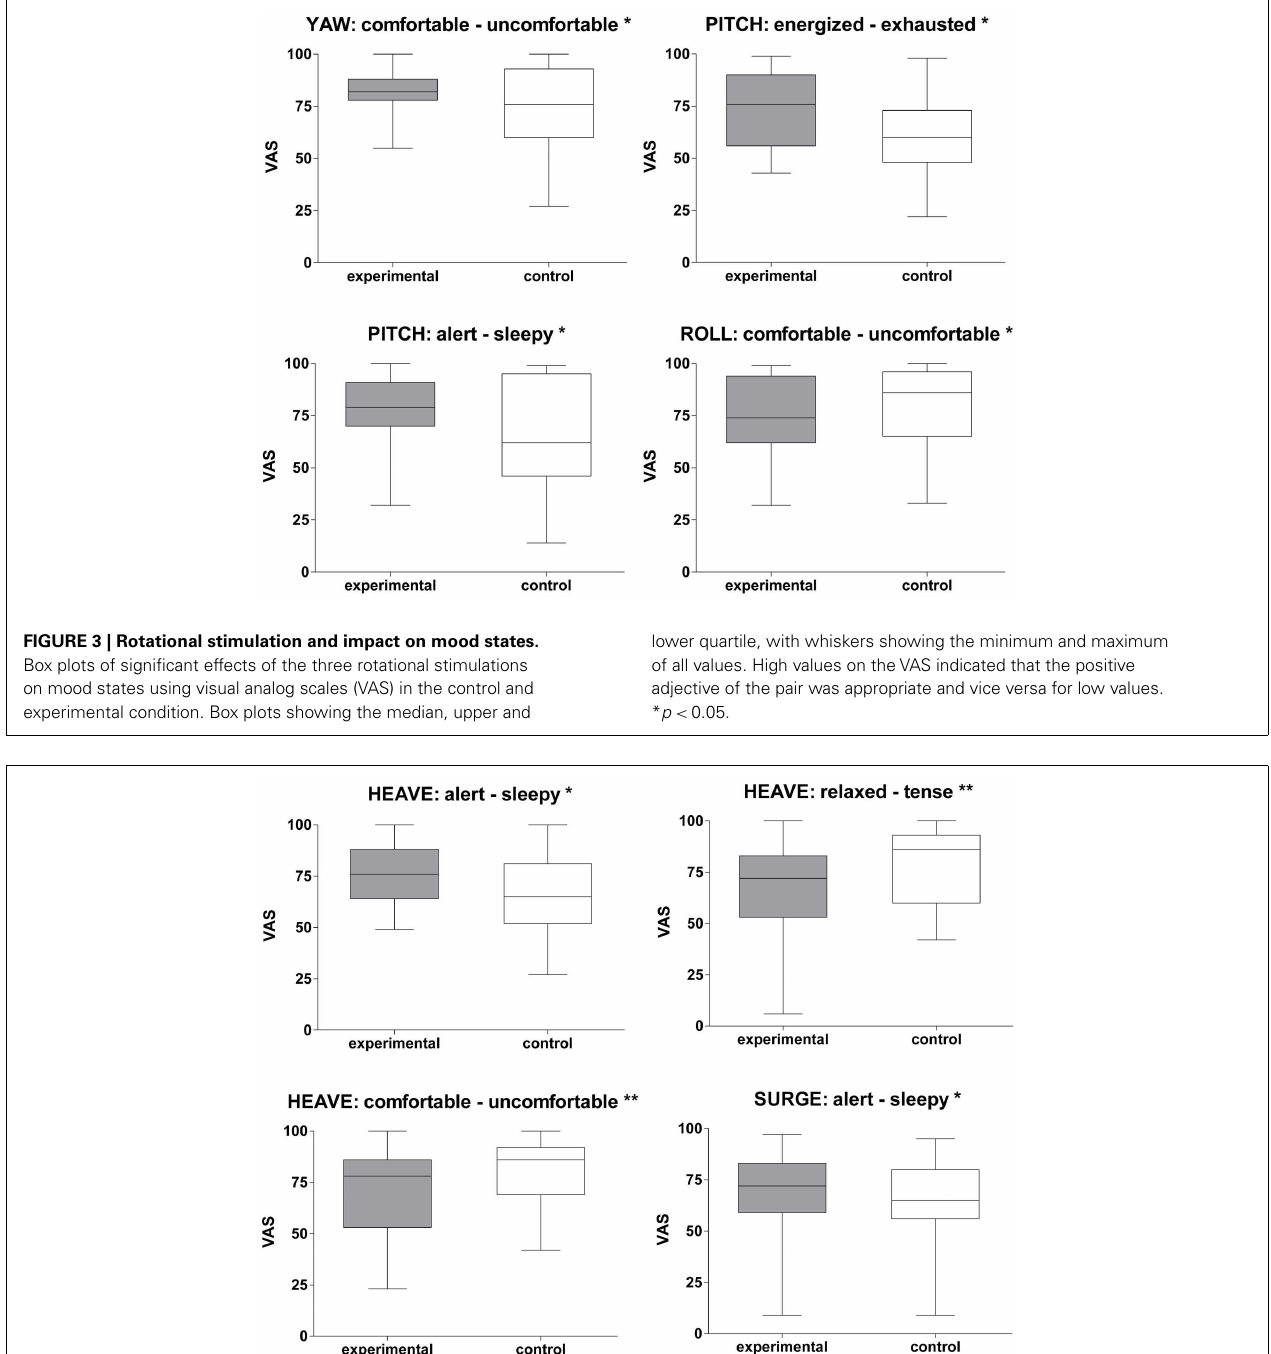
FIGURE 4 |Translational stimulation and impact on mood states. Box plots of significant effects of two translational stimulations (surge and heave) on mood states usingVAS scales in the control and experimental condition. Box plots showing the median, upper, and